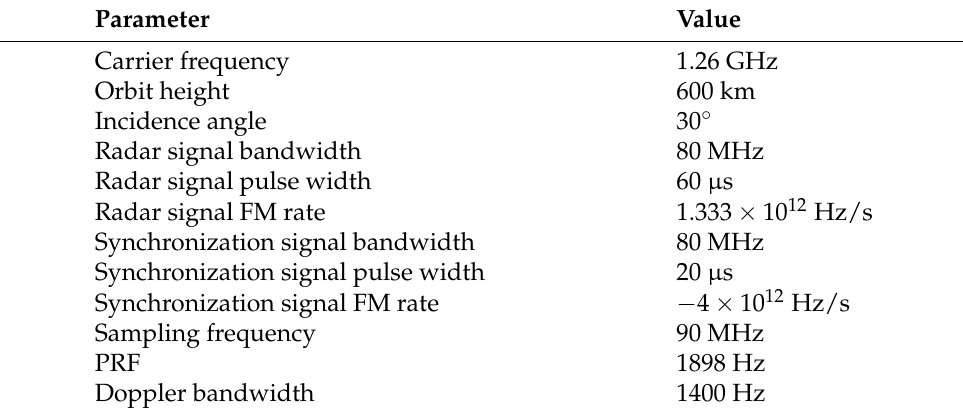
Table 3. Parameters in Distributed Targets Simulation.